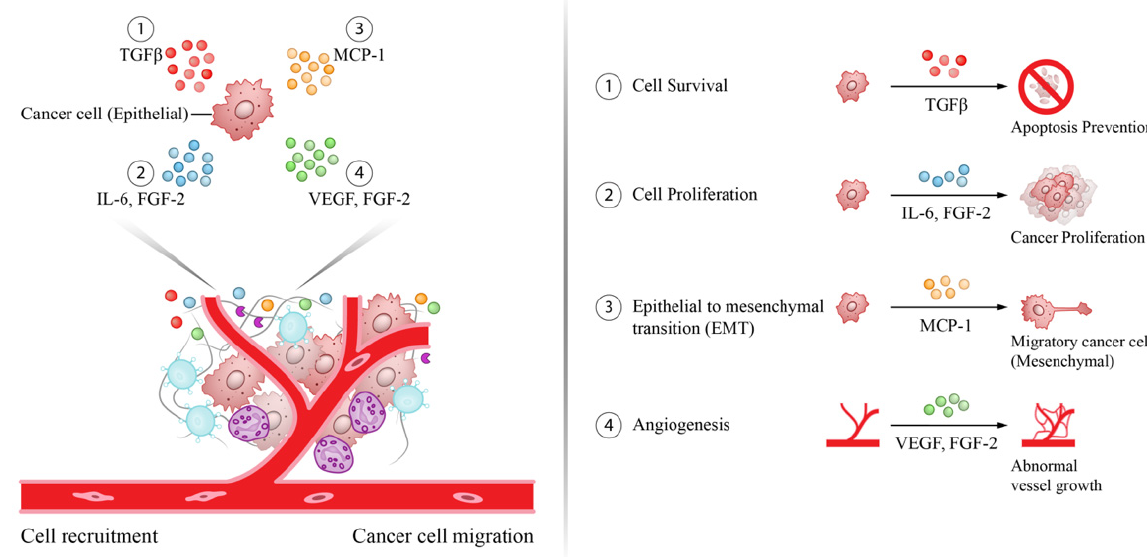
Figure 2. Pro-carcinogenic cytokines in the tumor microenvironment involved in HCC formation. Effect of selected cytokines in the tumor microenvironment contributing to HCC formation by promoting cancer cell survival (TGF- β ), proliferation (IL-6, FGF-2), epithelial mesenchymal transformation (MCP-1), and angiogenesis (VEGF, FGF-2).